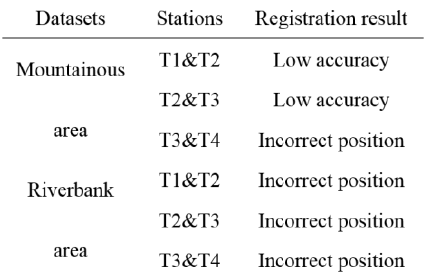
Table 3. Registration results by CPD algorithm